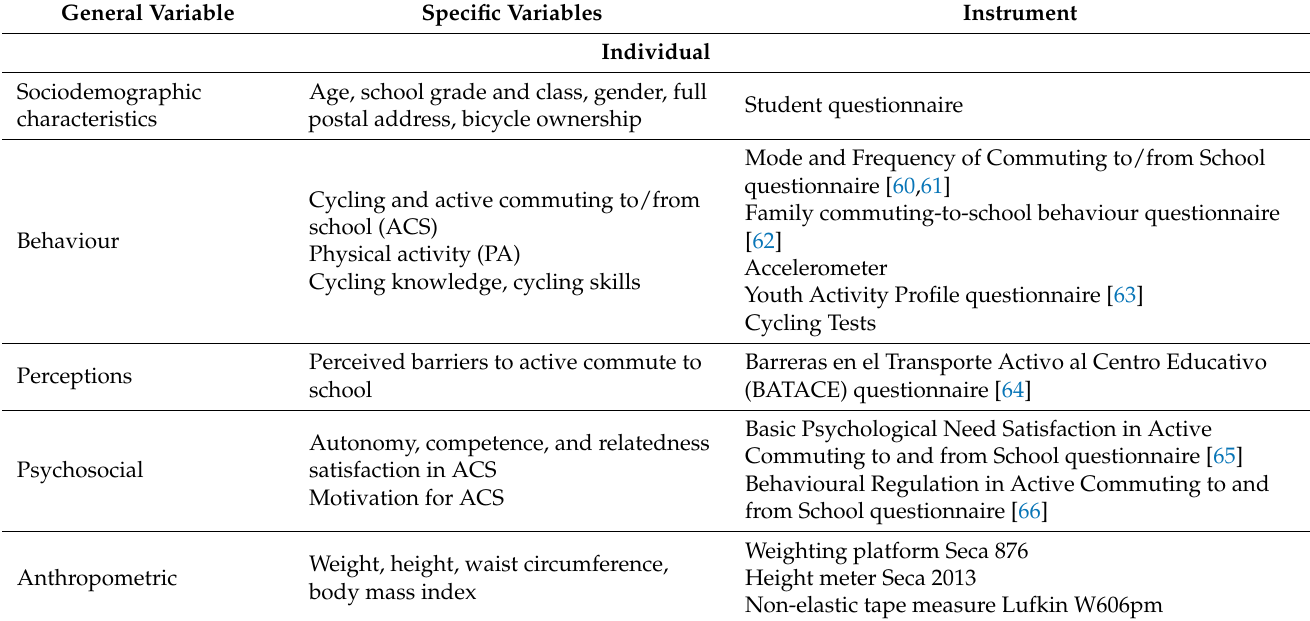
Table 1. Summary of the variables and instruments, following the levels of influence of the social-ecological model (SEM). General Variable Specific Variables